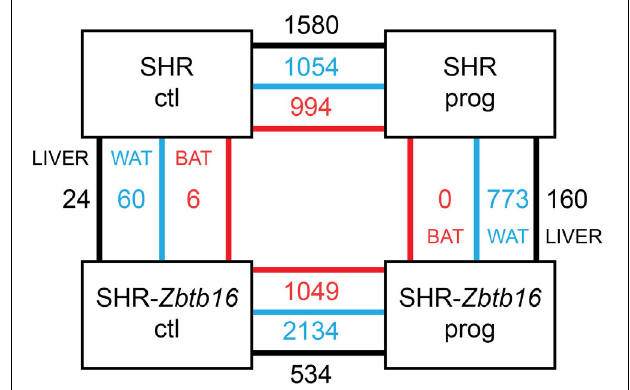
FIGURE 11 | Schematic depiction of transcriptome results comparison in adult male offspring of SHR and SHR- Zbtb16 rat strains. Numbers of significantly differentially expressed transcripts (FDR < 0.05, > 1.5-fold-change) between control (ctl) and maternally programmed (prog) groups of both strains are shown for liver (black lines), white adipose tissue (WAT, blue lines) and brown adipose tissue (BAT, red